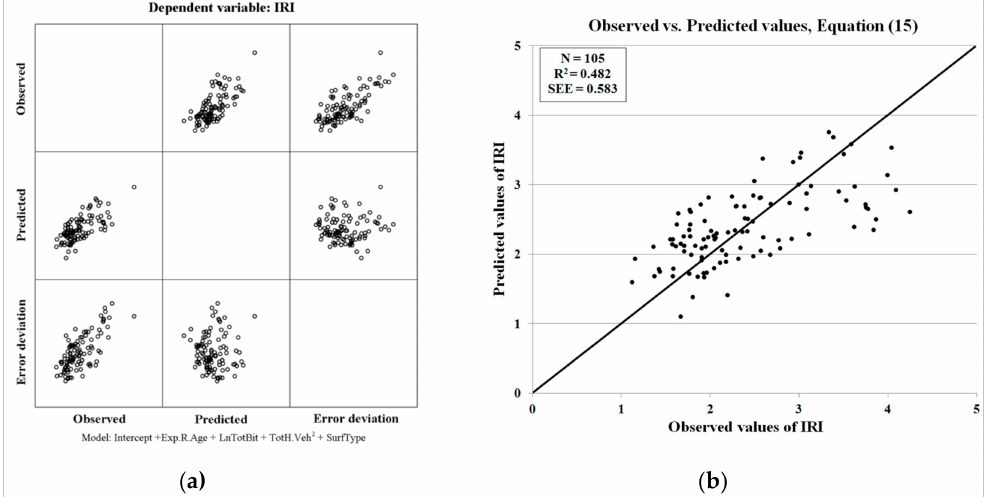
Figure 3. Statistical analysis of model of Equation (15). ( a ) Plot of residuals (standardized), observed and predicted values; ( b ) Observed vs. predicted